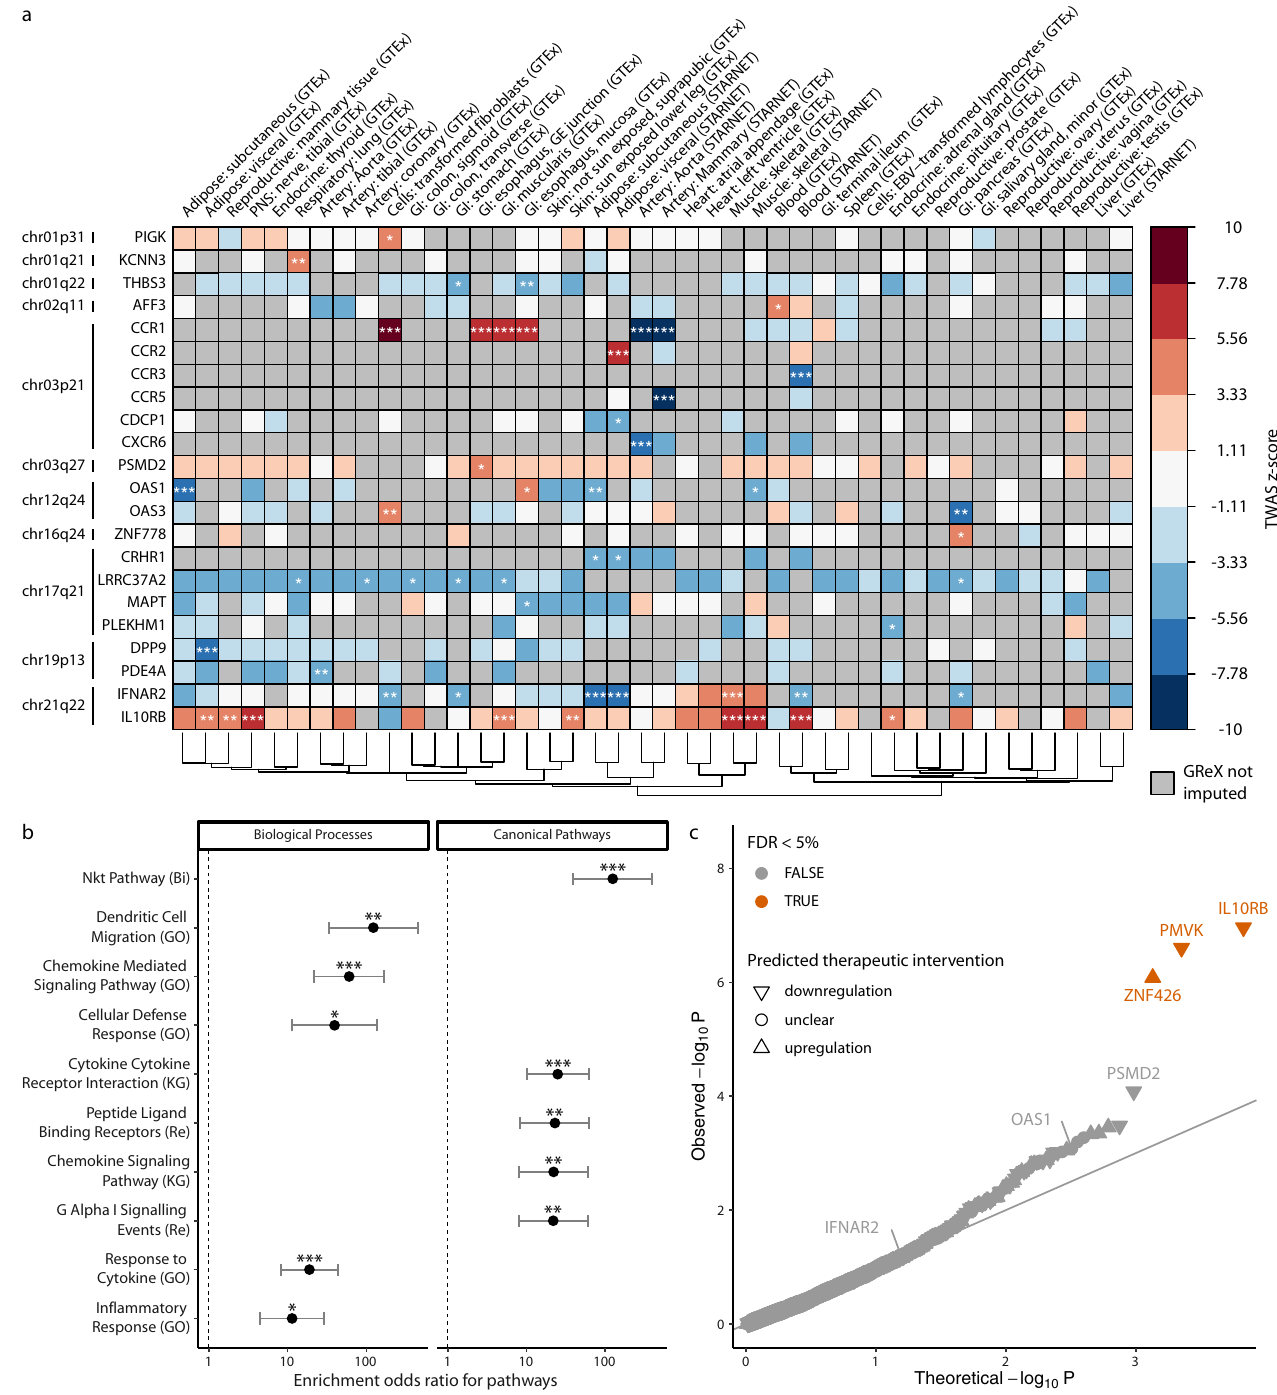
association with severity or death controls for age, sex, Elixhauser ’ s comorbidity score 15 , and ancestry-speci fi c population structure (Fig. 3a). To better understand the phenotypic variation linked with IL10RB and IFNAR2 imputed expression, we next performed a phenome-wide association study (PheWAS) utilizing the IL10RB and IFNAR2 GReX models in MVP (Fig. 3b; cohort characteristics in Supplementary Table 3; Supplementary Data 9 for a complete set of results). For IL10RB , among signi fi cant results, we found that COVID-19-related GReX dysregulation (higher IL10RB GReX in